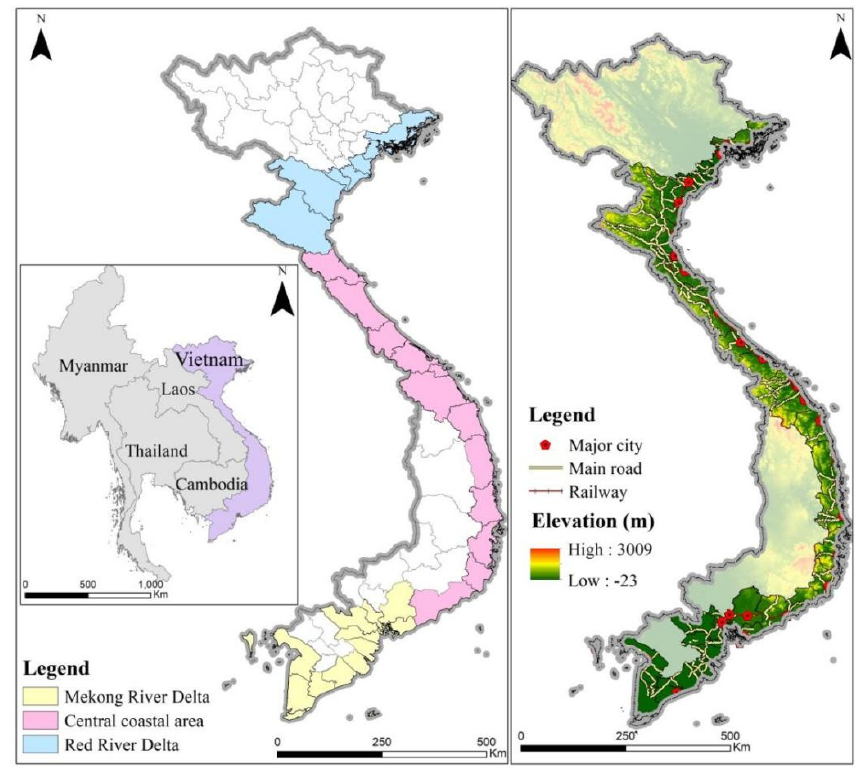
Figure 1. The location map of the study area.